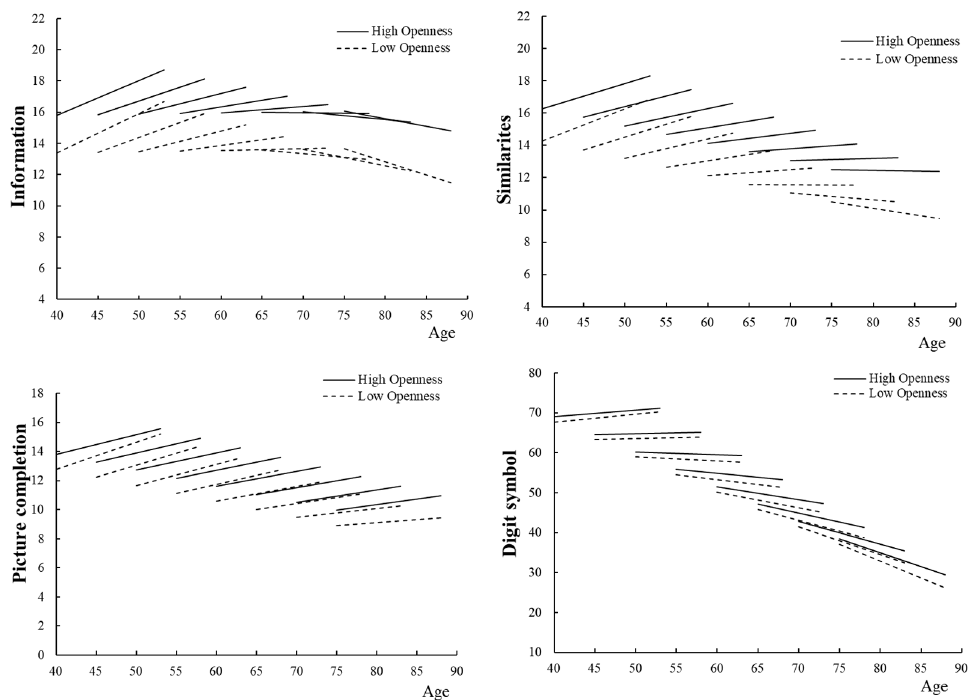
Figure 1. Model-predicted 13-year changes in cognitive abilities by openness and baseline age. The solid lines are estimated for individuals with a high openness level (openness score = 30.12); the dashed lines are estimates for individuals with a low openness level (openness score = 21.46). Higher scores indicate a better performance. Possible score for the information is 0–29; similarities 0–28; picture completion 0–21; and digit symbol 0–93. The models controlled for sex, education level, marital status, occupation, smoking, past and present illness, and practice effects.